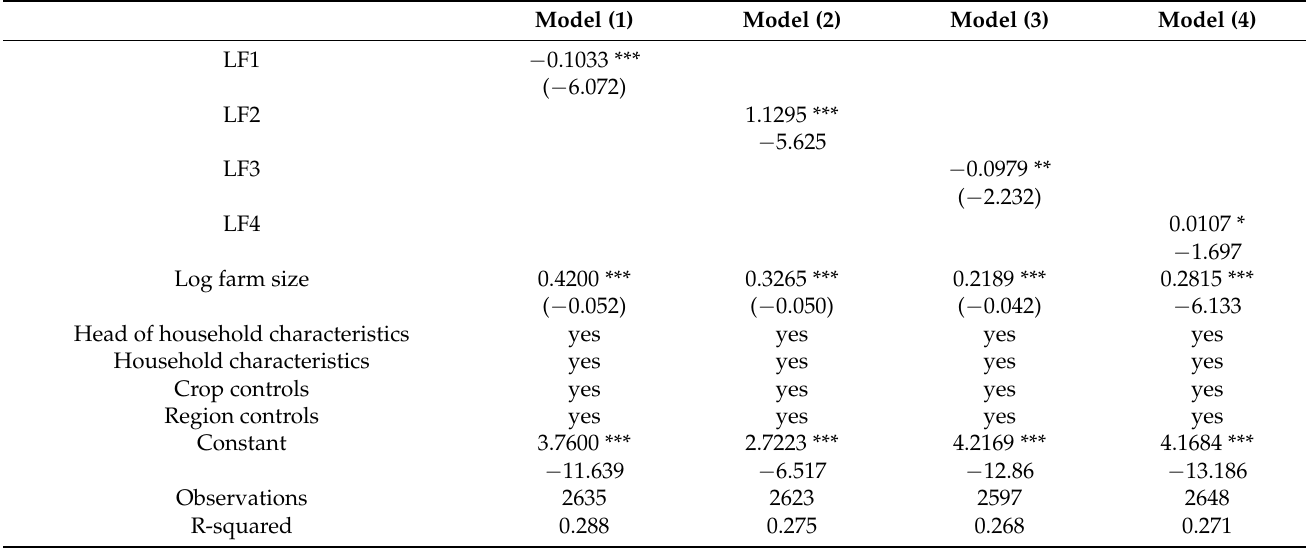
Table 5. Results of LF on purchase machinery service.